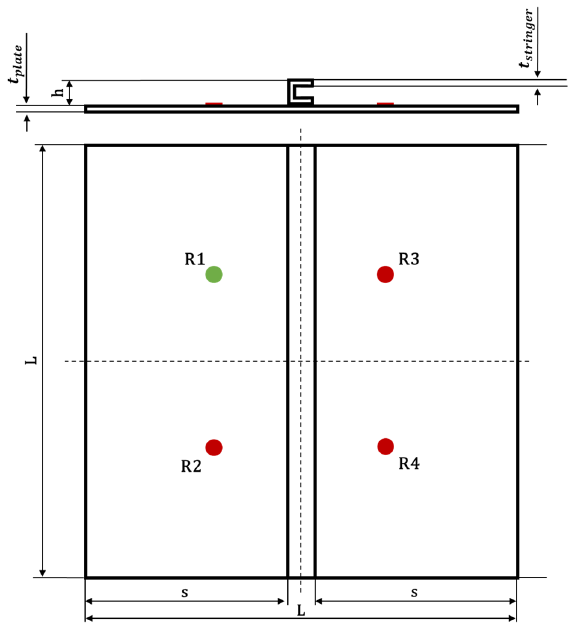
Figure 2. Stiffened panels geometry.